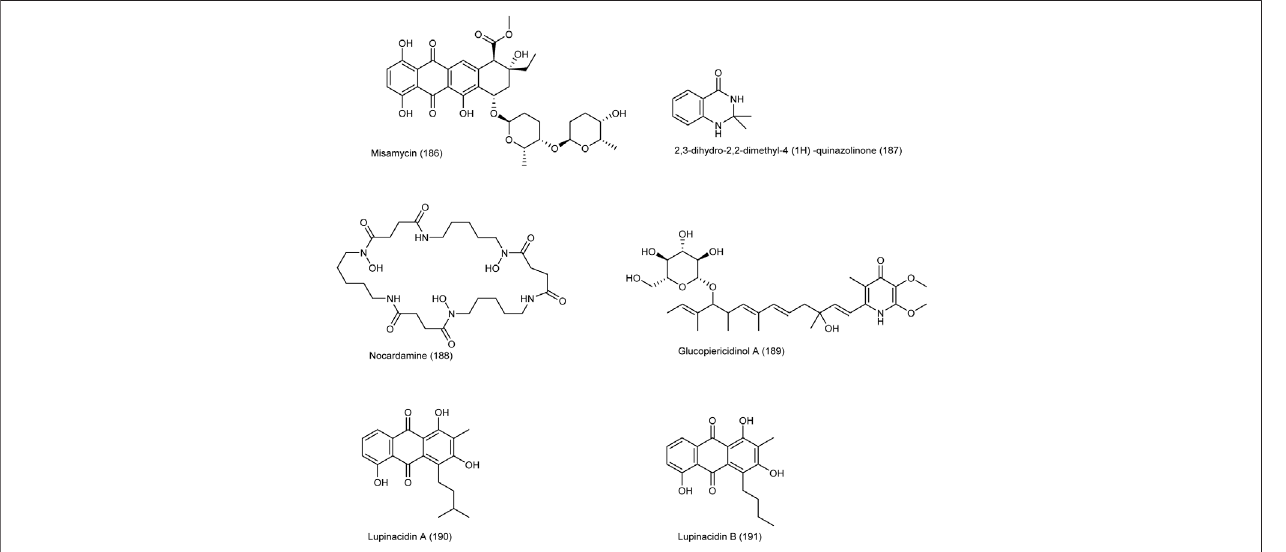
FIGURE 7 | Chemical structure of NPs produced by endophytic strains of actinobacteria.